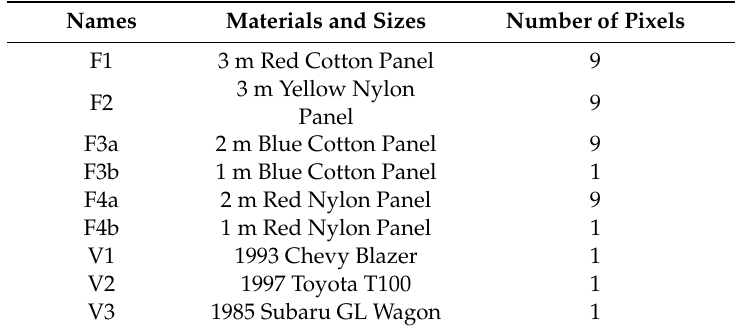
Table 1. Details of the fabric panels and vehicles used as targets in the HyMap dataset.